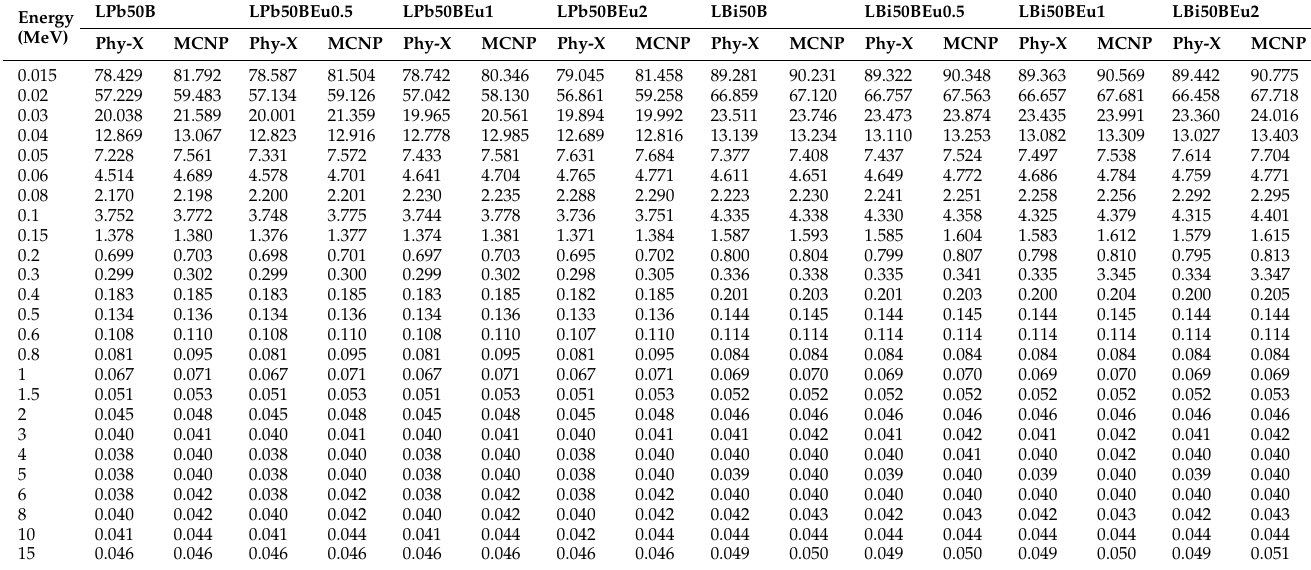
Table 2. Obtained mass attenuation coefficients from MCNPX code and Phy-X/PSD